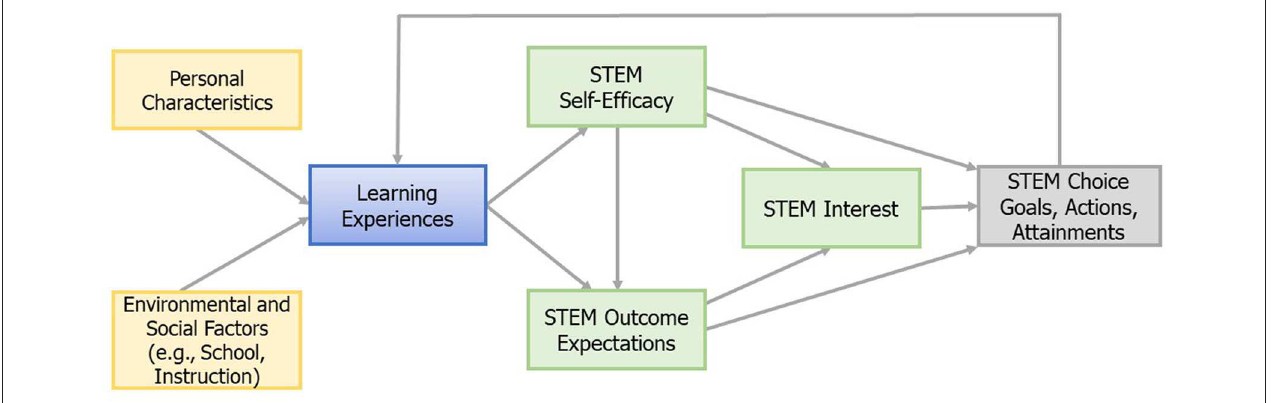
FIGURE 1 | Self-efficacy, outcome expectations, interest as key variables for formation of STEM